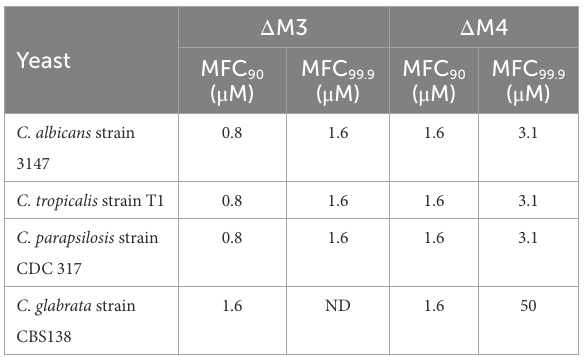
TABLE 2 Minimal fungicidal concentrations (MFC 90 and MFC 99.9 ) of Δ M3 and Δ M4 against yeast cells of Candida species.